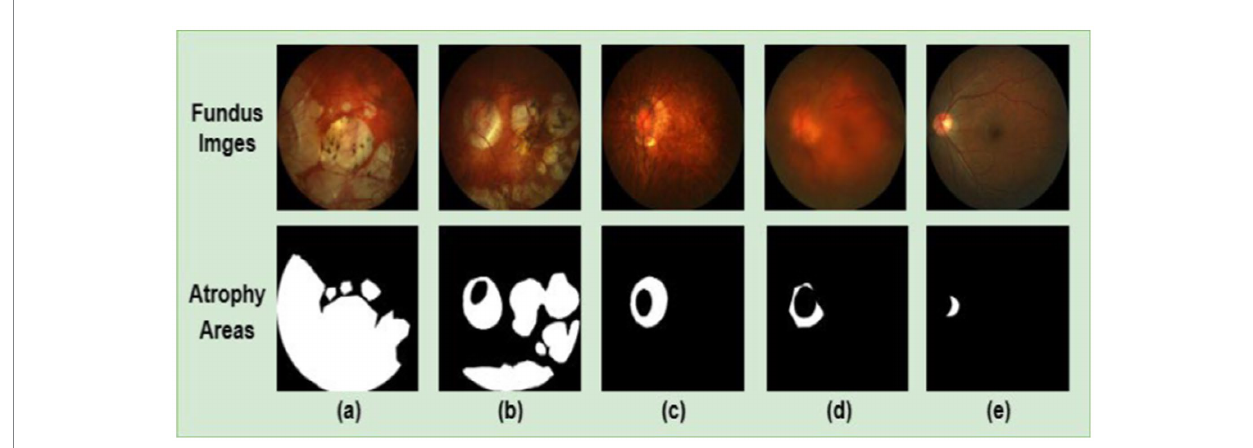
FIGURE 1 2D fundus images (top part) and the corresponding retinal atrophic areas (bottom part). Subfigures (A–D) are fundus images of patients with PM. Subfigure (E) is a fundus image of patients with non-pathological myopia. PM images have more significant retinal atrophic regions than non- pathological myopia